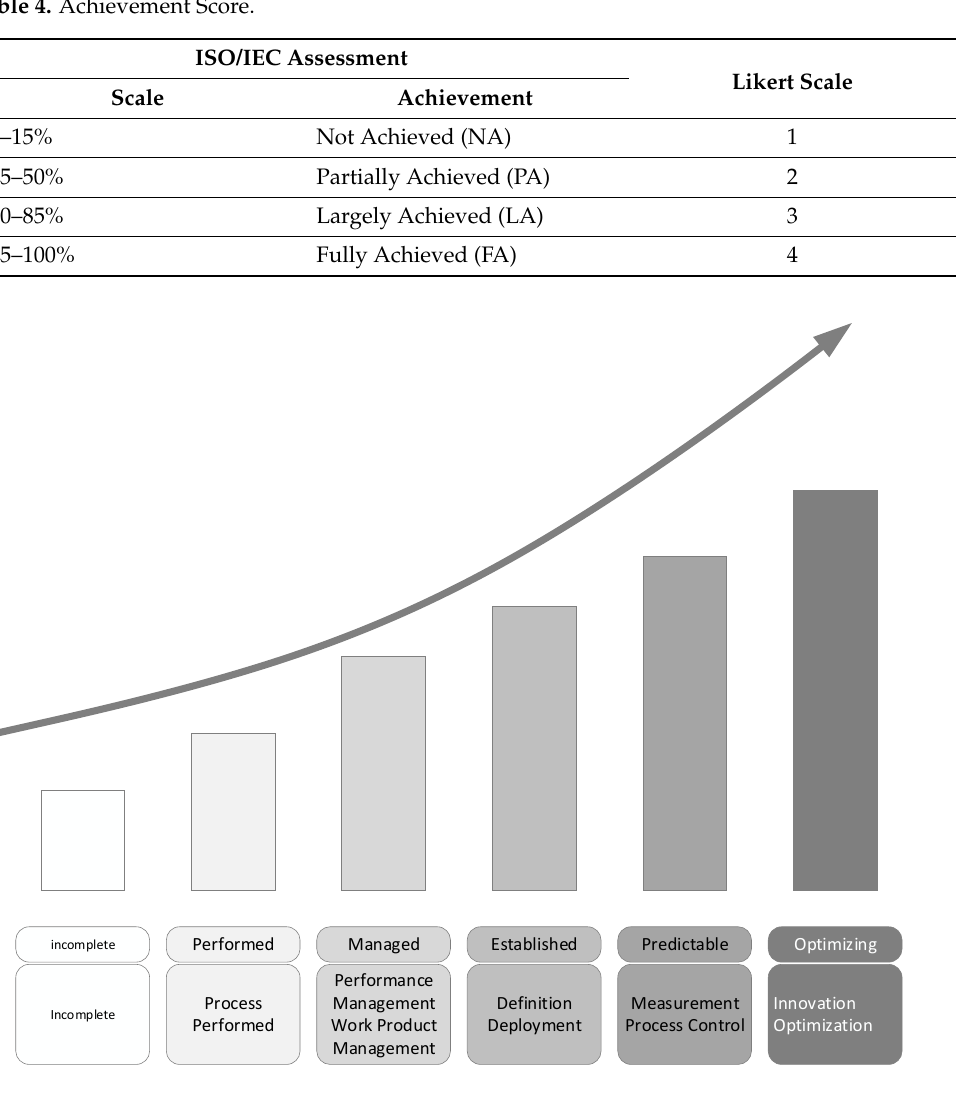
Figure 5. Digital Maturity Level.